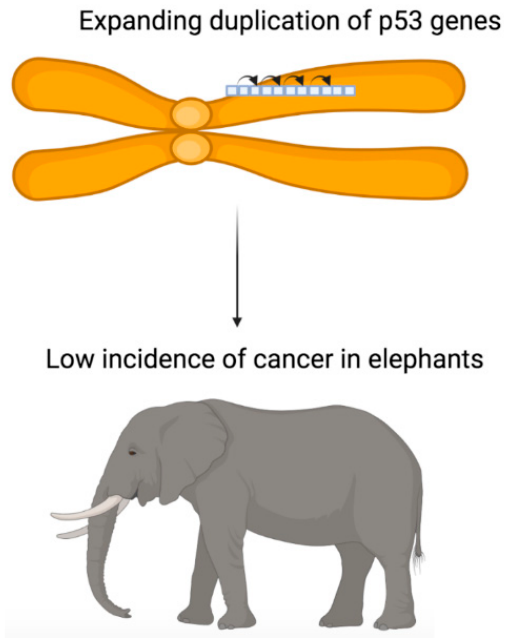
Figure 1. The massive tandem duplication of the p53 gene may promote stronger protection against DNA damage in elephant cells, especially cancers, than in other species such as humans. This figure was created using(cid:31)BioRender (https://biorender.com/, accessed on 1 July 2022).